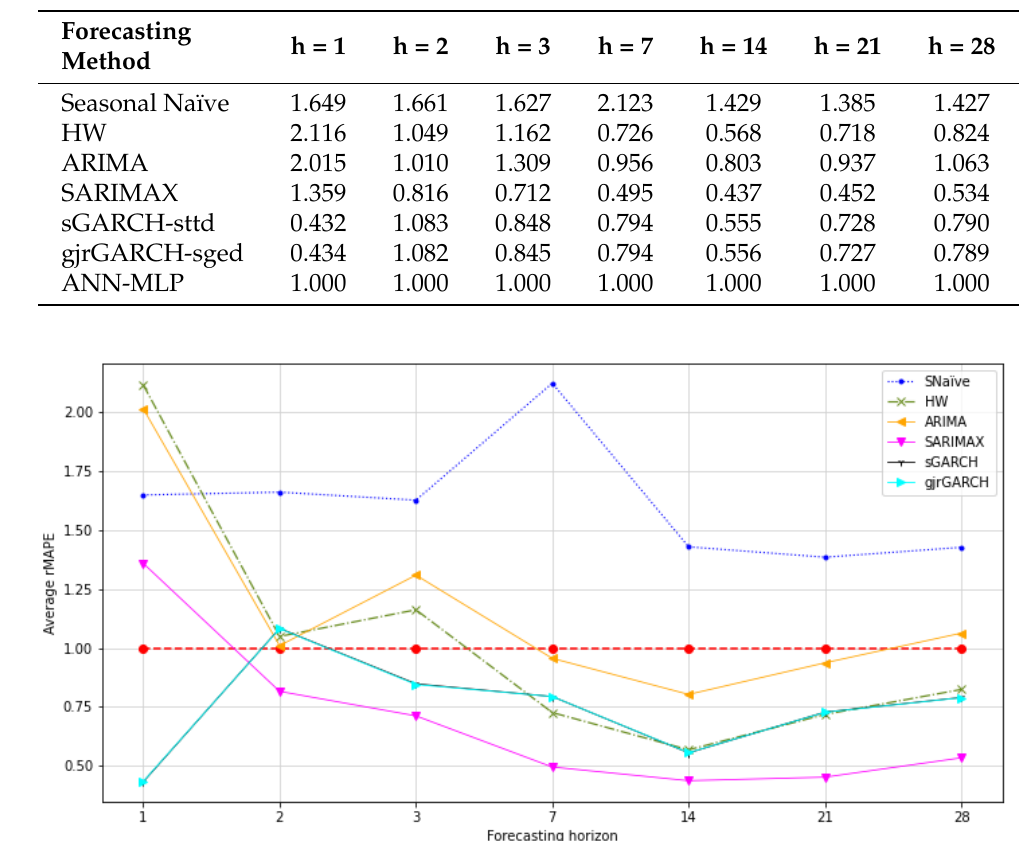
Table 3. Average rMAPE of forecasting methods.